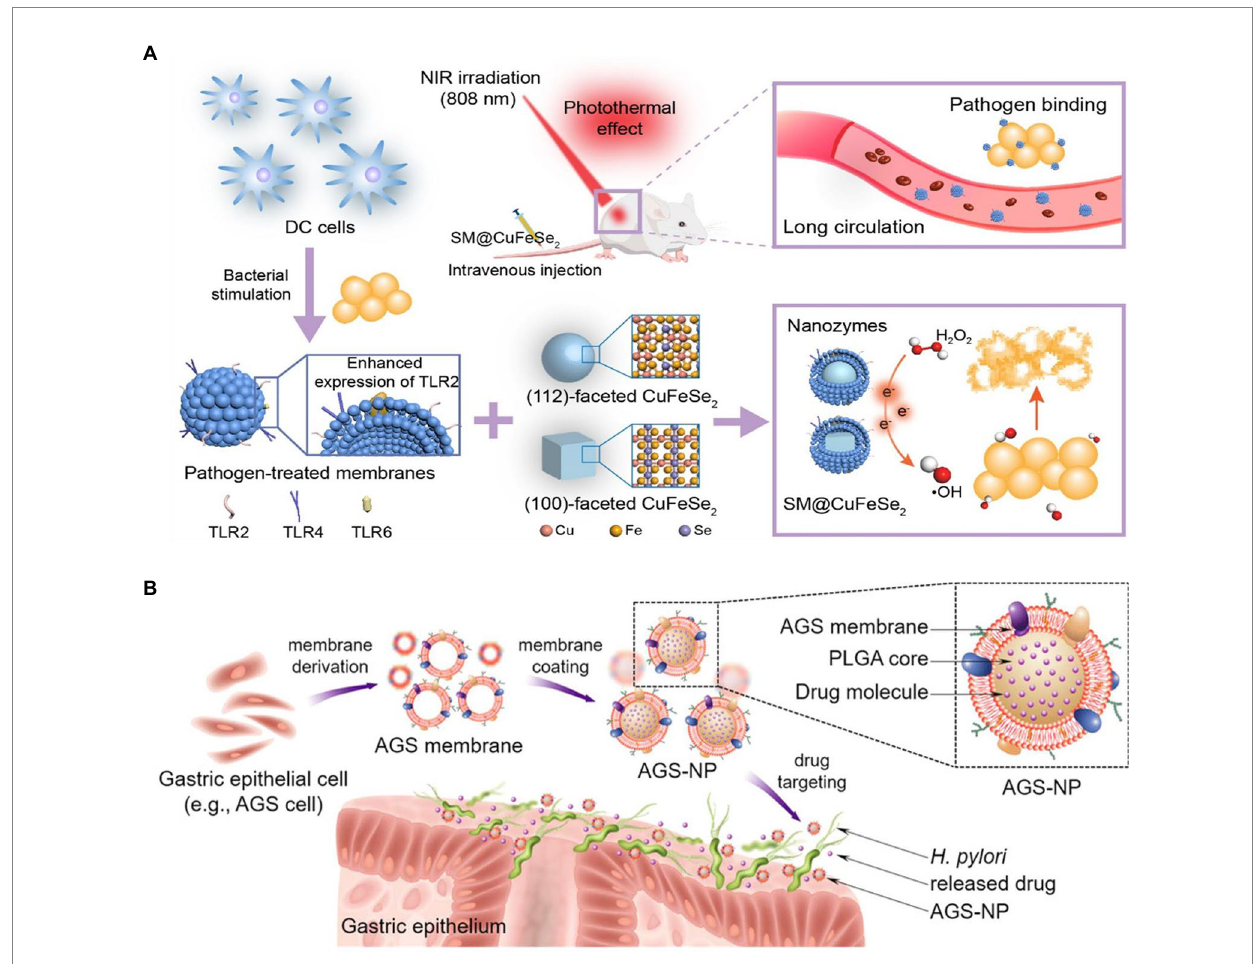
FIGURE 6 (A) Construction of dendritic cell (DC) membrane coated CuFeSe2 nanocrystals and their therapeutic application with NIR in bacterial infection (TLR, SM@CuFeSe 2 and NIR referred to toll-like receptor, pathogen-pretreated membrane-coated CuFeSe 2 and near-infrared, respectively). Reproduced with permission (Hou et al., 2021; Copyright© 2021, American Chemical Society). (B) Schematic illustration of the developed of gastric epithelial cell membrane-coated PLGA nanoparticles’ application in targeted antibiotic delivery for treating Helicobactor pylori infection. Reproduced with permission (Angsantikul et al., 2018; Copyright© 2018,